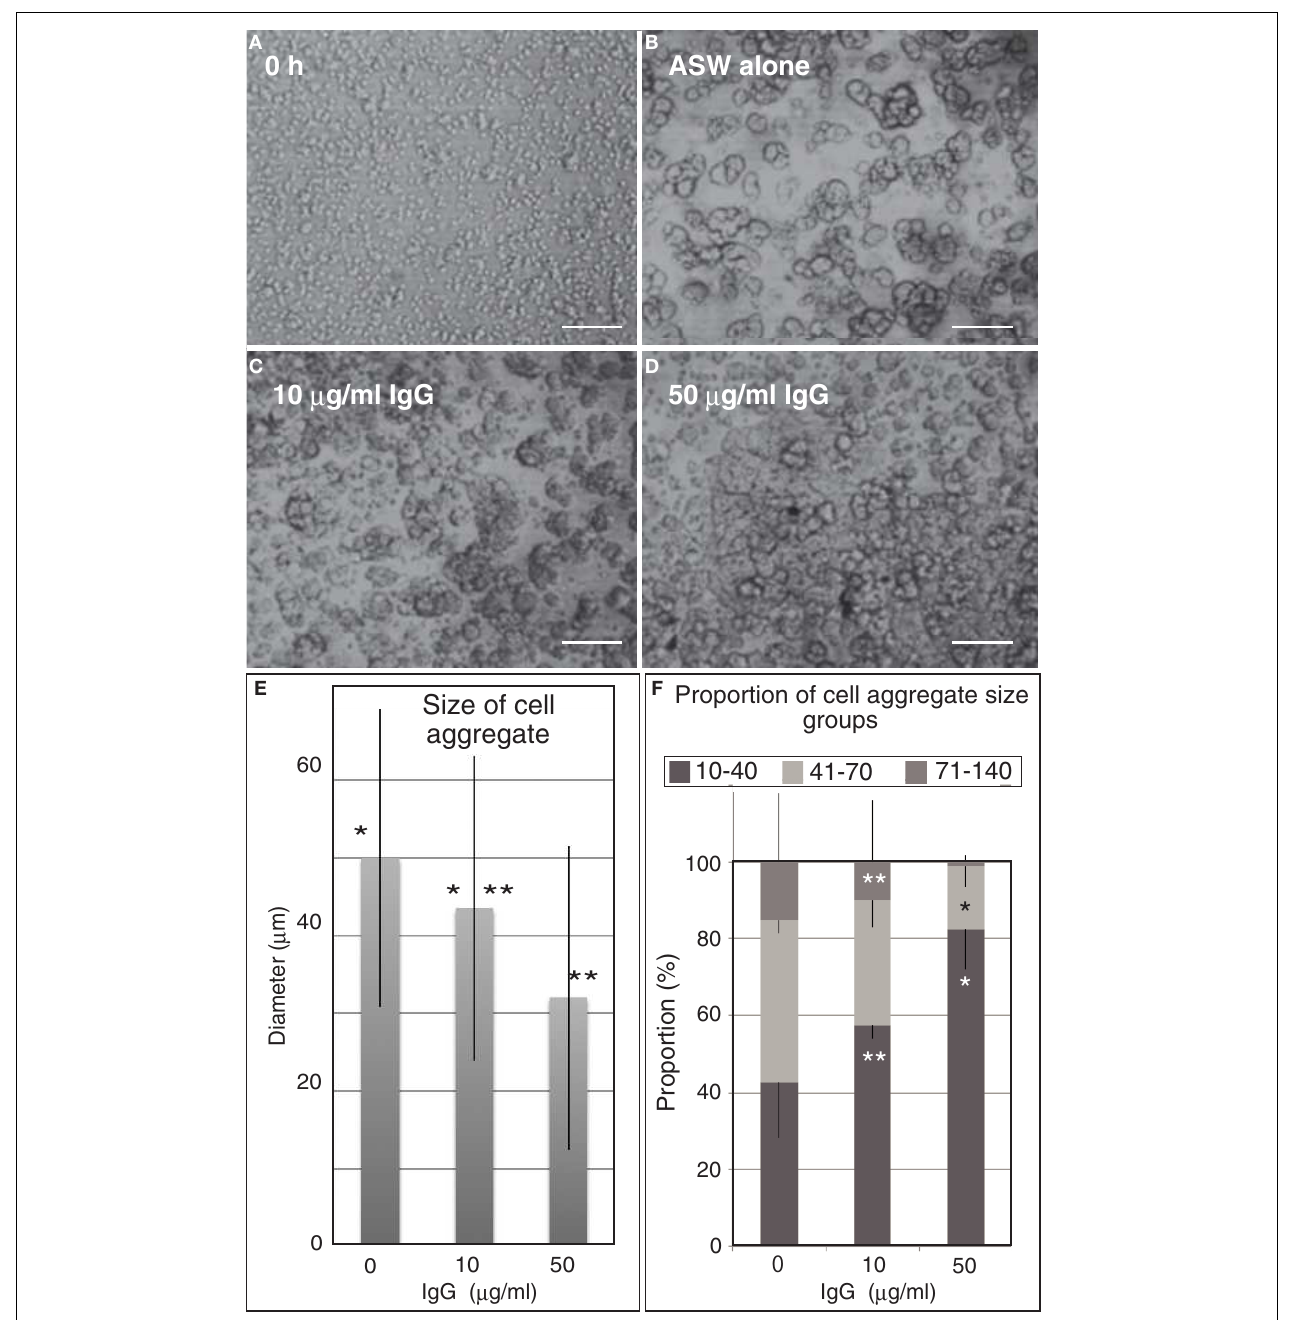
50 µ g/ml IgG (50 µ g/ml IgG). Scale bars, 100 µ m. (E) Average size of cell aggregates with no IgG (0), 10 µ g/ml (10) and 50 µ g/ml (50) IgG. Bars, SD ( n = 80). * P = 0.0344, ** P = 0.0001. Unpaired t test. (F) Proportion of three cell aggregate sizes in 0 µ g/ml (0), 10 µ g/ml (10), and 50 µ g/ml (50) anti-Epith-2 mAb IgG. Bars, SD ( n = 80). * P = 0.0055, ** P = 0.0588. Unpaired t